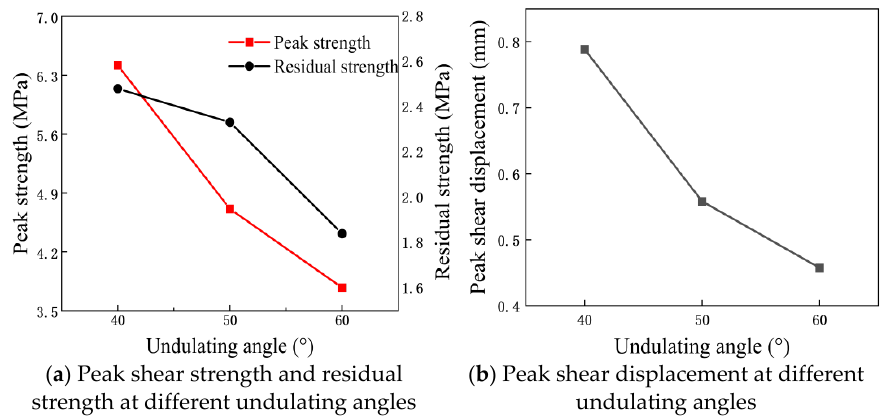
Figure 7. Shear strength curves under the influence of different undulating angles.